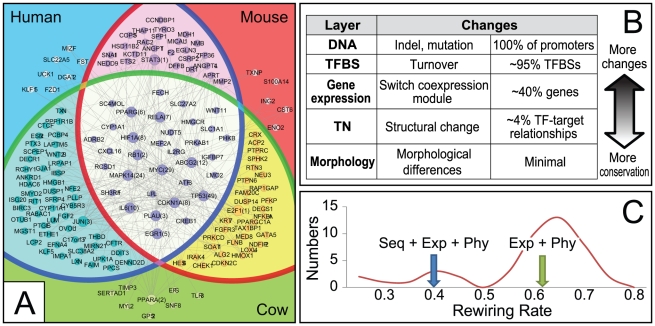
Conservation and rewiring of Oct4 downstream TN.(A) Venn diagram of model-inferred Oct4 target genes in three species. Each node is a gene and each edge represents a transcriptional regulatory link. When a set of genes are linked to a regulatory hub gene, this set of genes is suppressed into one node, annotated with the name of the hub gene followed by the number of other genes transcriptionally linked to the hub. (B) Inferred conservation levels for DNA, TFBS, gene expression, TN, and morphology. (C) Comparison of model-inferred re-wiring rates with (Exp+Seq+Phy) and without (Exp+Phy) DNA sequence data. The re-wiring rate of TF was calculated as the percentage of non-conserved TF-target relationships among all TF-target relationships. A background distribution (red curve) of the re-wiring rate is derived from randomly permuting the rows and columns of the Oct4 position specific score matrix (PSSM) and feeding the permutated PSSM to the model with unperturbed sequence and gene expression data.